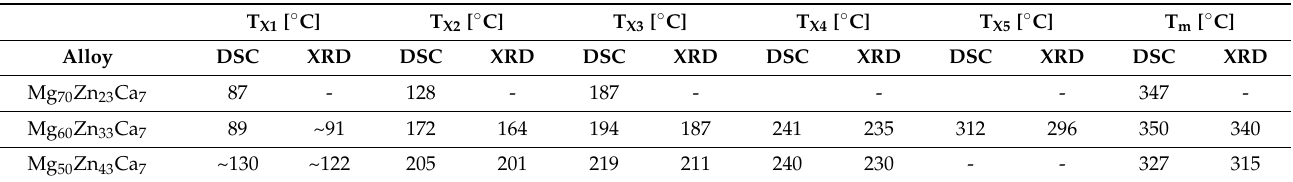
Table 5. Crystallisation temperatures determined by DSC and in situ HEXRD measurements at a heating rate of 10 °C per minute.